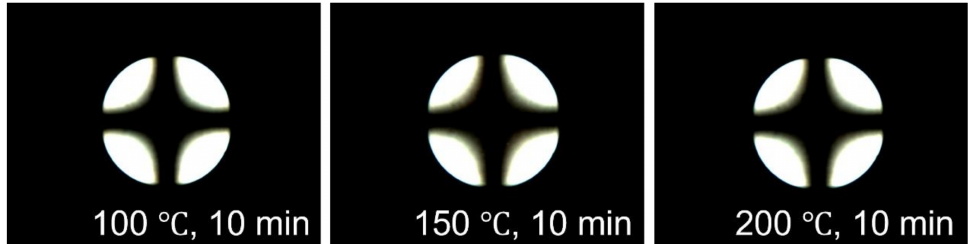
Figure 8. Concoscopic POM images of the LC cells made PD t BP88 films, after thermal treatment at 100, 150, and 200 ◦ C for 10 min, respectively.